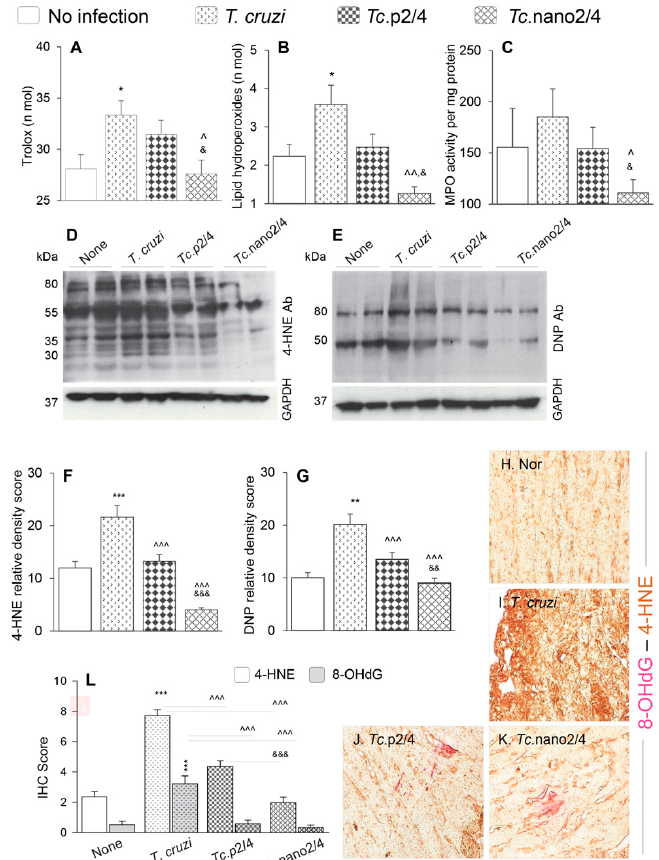
Figure 4. Control of systemic antioxidant and oxidant status in Chagas mice treated with nano-immunotherapy. Mice were infected, treated, and euthanized as described in Figure S1. ( A – C ) Shown are serum levels of ( A ) total antioxidant capacity, ( B ) lipid hydroperoxides levels, and ( C ) myeloperoxidase (MPO) activity. Data are presented as mean value ± SD ( n = 5 mice per group, duplicate observations per sample per experiment). ( D – G ) Heart homogenates (20 µ g) were resolved by SDS-PAGE. Representative Western blot images for 4-hydroxynonenal (4-HNE) (D) and dinitrophenyl (DNP) derivatized protein carbonyls ( E ) are shown. GAPDH was probed as a loading control. Relative densitometry score for 4-HNE ( F ) and DNP-carbonyls ( G ) was normalized to GAPDH and presented as mean value ± SD ( n = 4 mice per group, duplicate Western blot analysis per sample). ( H – L ) Myocardial tissue sections from di ff erent groups of mice were subjected to immunohistochemistry staining. Shown are representative images for 4-HNE / 8-OHdG (lipid peroxidation / oxidative DNA damage) levels in cardiac tissue of non-infected ( H ), infected ( I ), Tc .p2 / 4 ( J ), and Tc .nano2 / 4 ( K ) mice at 60 × magnification. Bar graph ( L ) shows the immunohistochemistry staining score (mean value ± SD) for 4-HNE and 8-OHdG ( n = 3 mice per group, 2 tissue sections per mouse, 9 microscopic fields per tissue section, analyzed at 20 × magnification). For data presented in bar graphs, significance was calculated and annotated as described in Figure